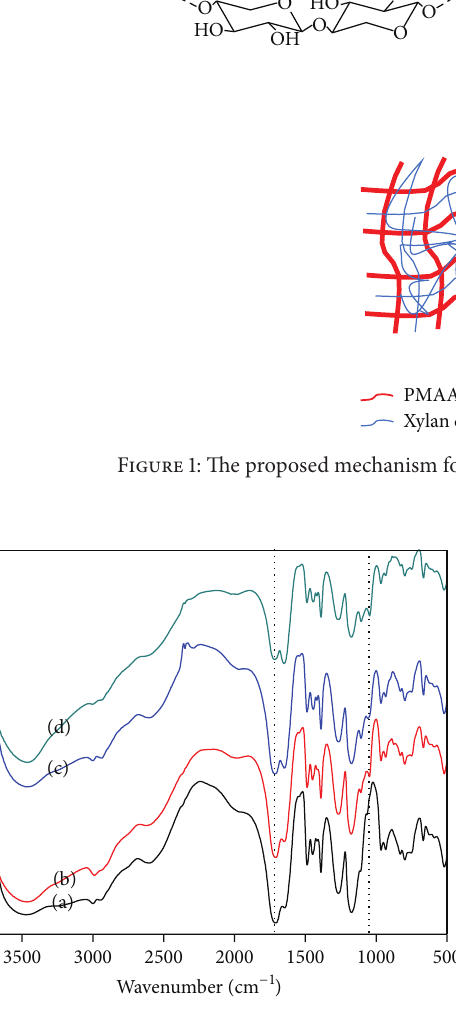
Figure 2: FT-IR spectra of PMAA (a), semi-IPN2 (b), semi-IPN5 (c), and semi-IPN7